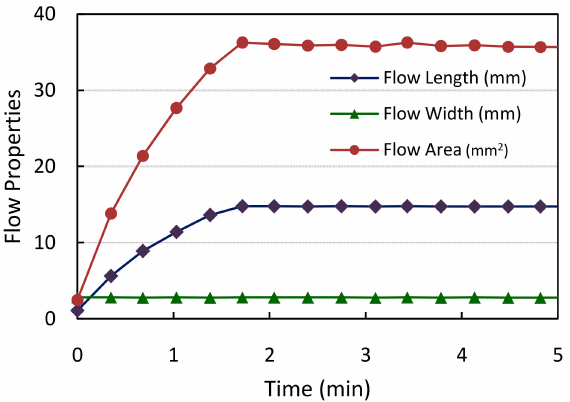
Figure 15. The measured flow length, width, and area for a sample HbA1C cartridge with respect to time using blood samples.